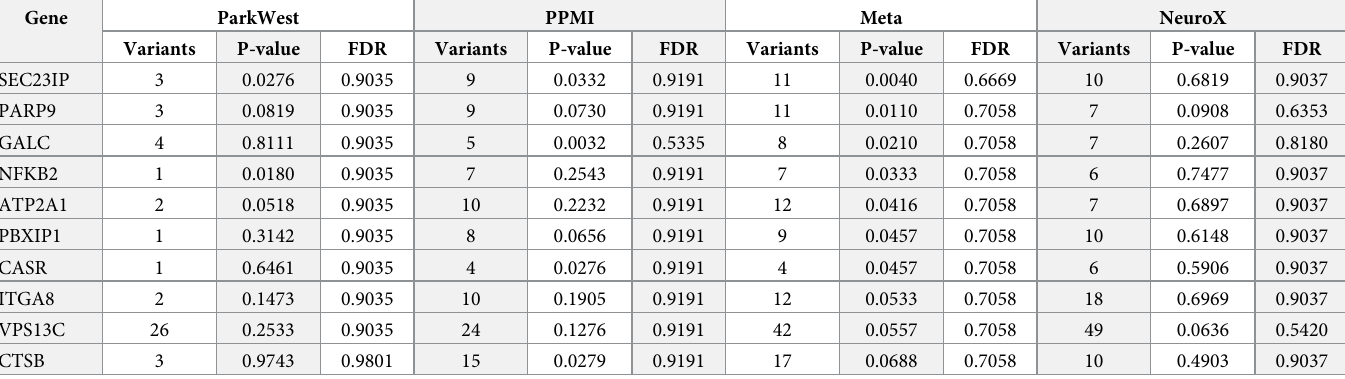
Table 1. Top results for burden-based gene enrichment analyses.